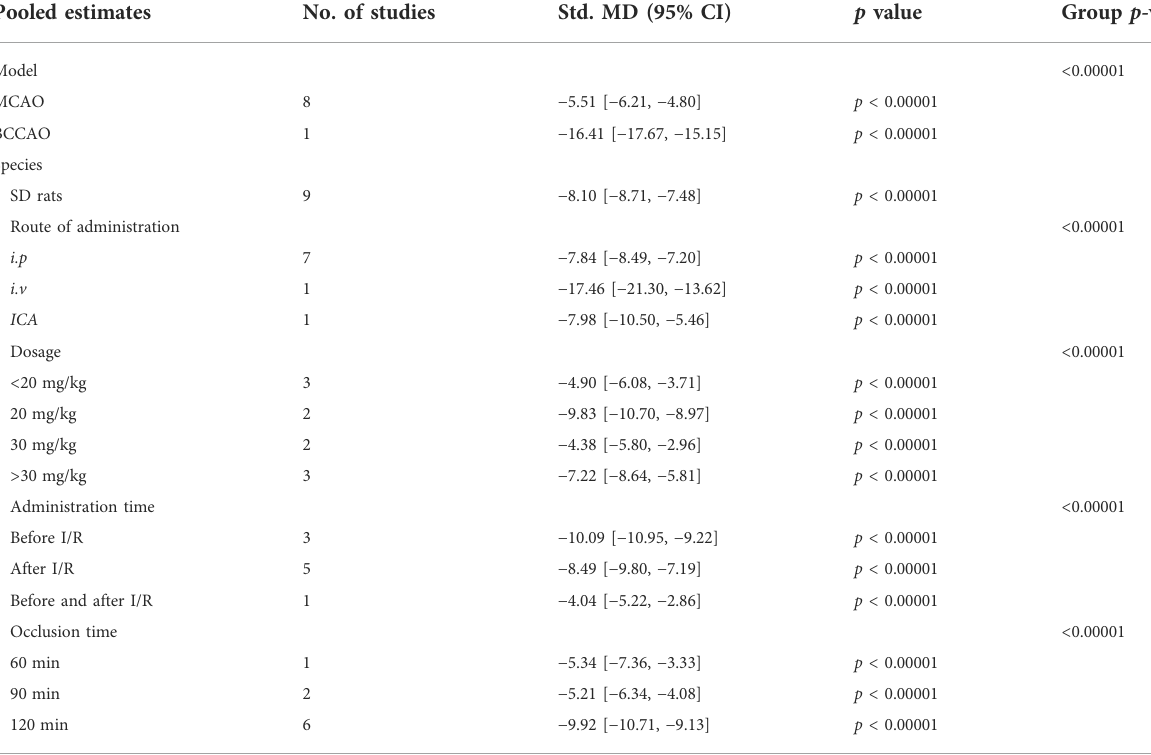
TABLE 4 Summary of subgroup analysis on brain water content. Pooled